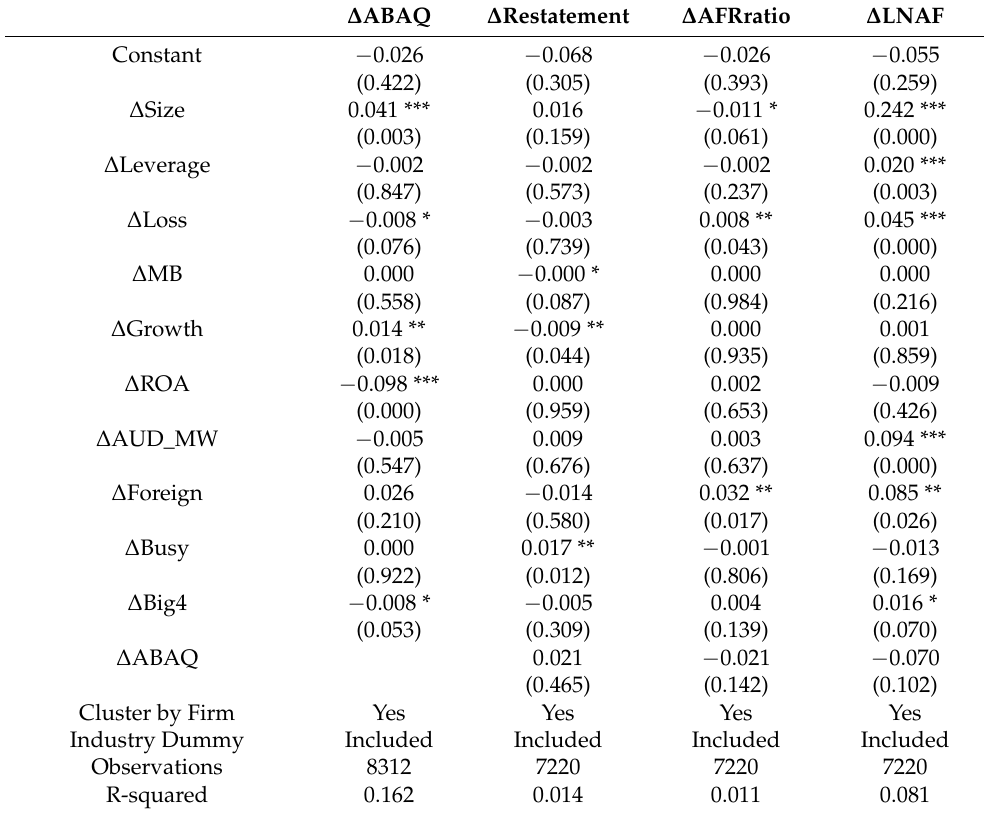
Table 5. Regression results of the association between PCAOB Rule 3211 and audit quality and audit fee for the US treated firms using 1st-differenced data. Panel A: One-year balanced panel designed ABAQ, Restatement, and AF of U.S. sample firms. ∆ ABAQ ∆ Restatement ∆